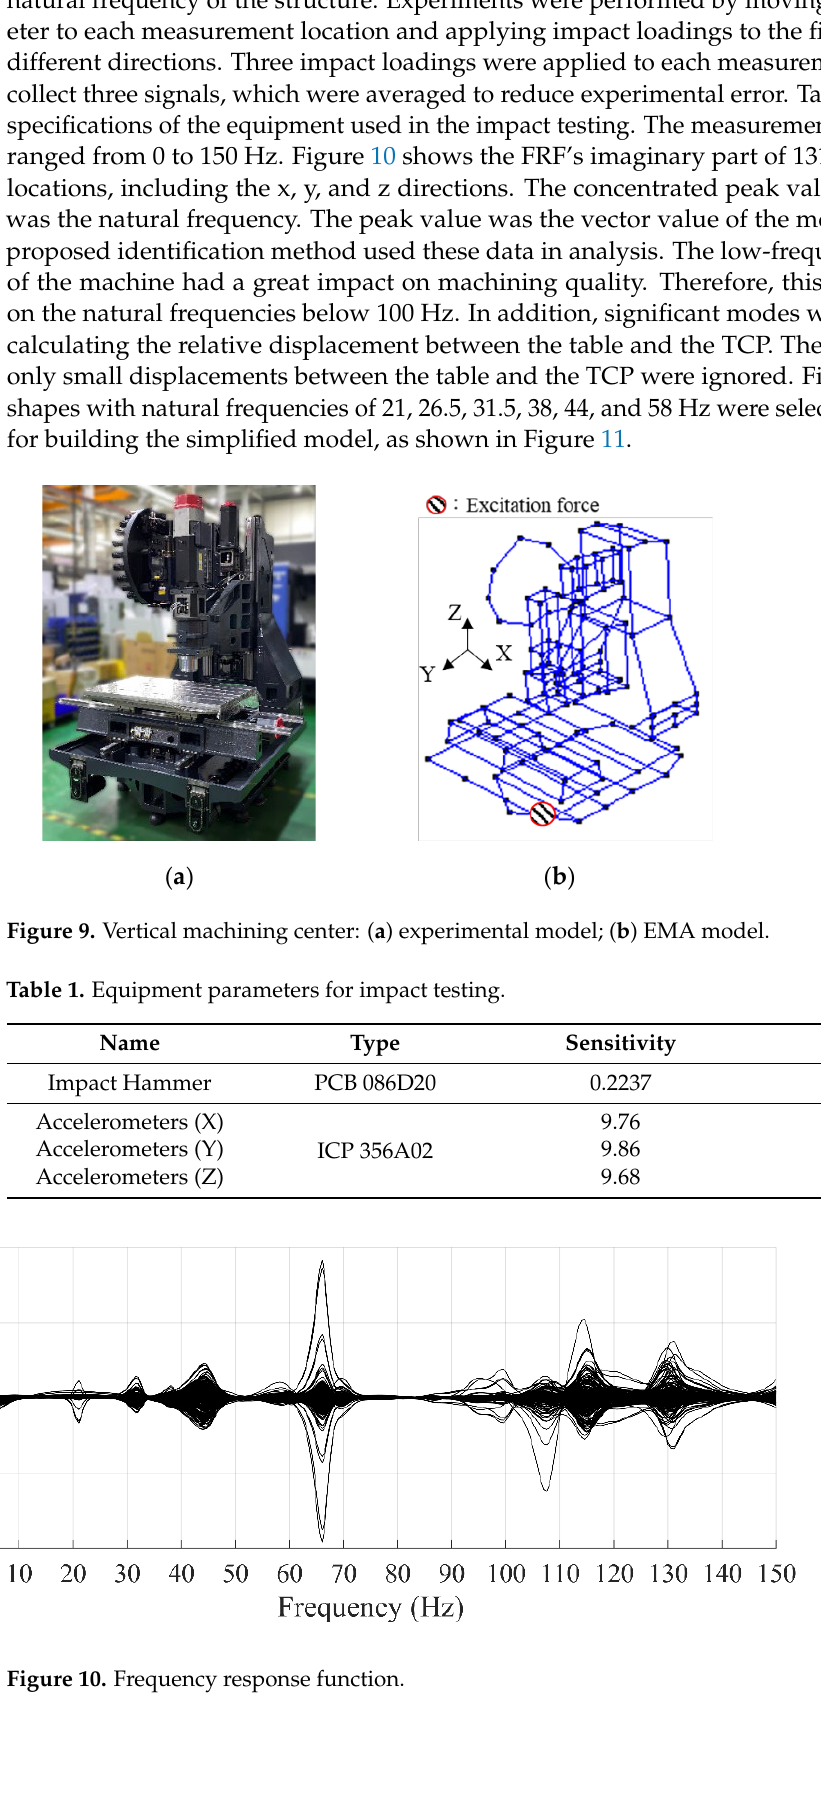
Figure 11. Experimental with the first six natural frequencies and mode shapes.